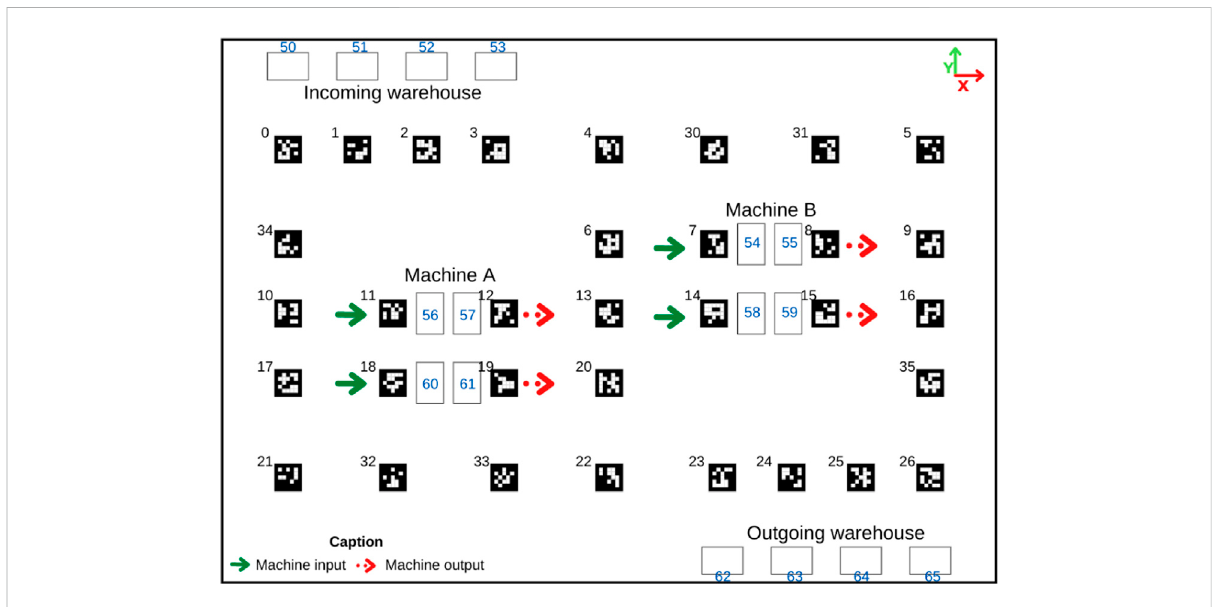
FIGURE 3 RAF of fi cial competition fl oor illustration Braun et al.